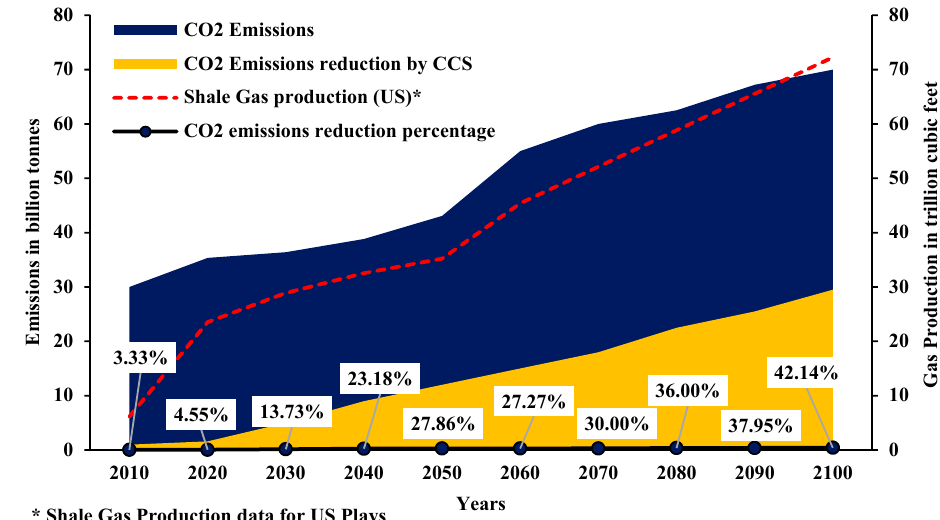
Figure 1. Carbon capture and storage (CCS) contribution percentage in CO 2 emission reduction from 2010 to 2100 [34–37].